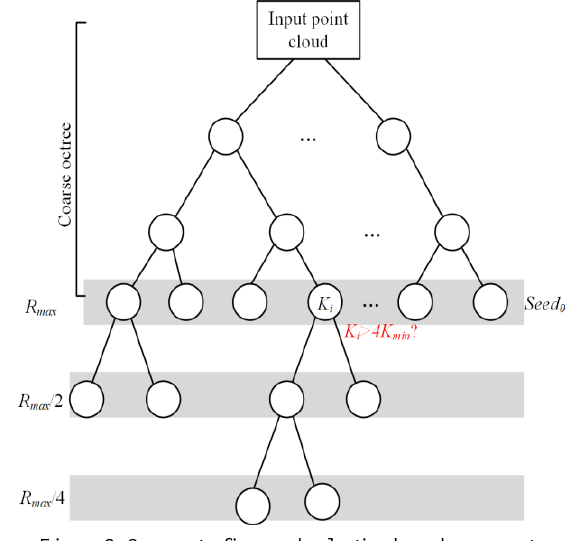
Figure 2. Coarse-to-fine seed selection based on an octree